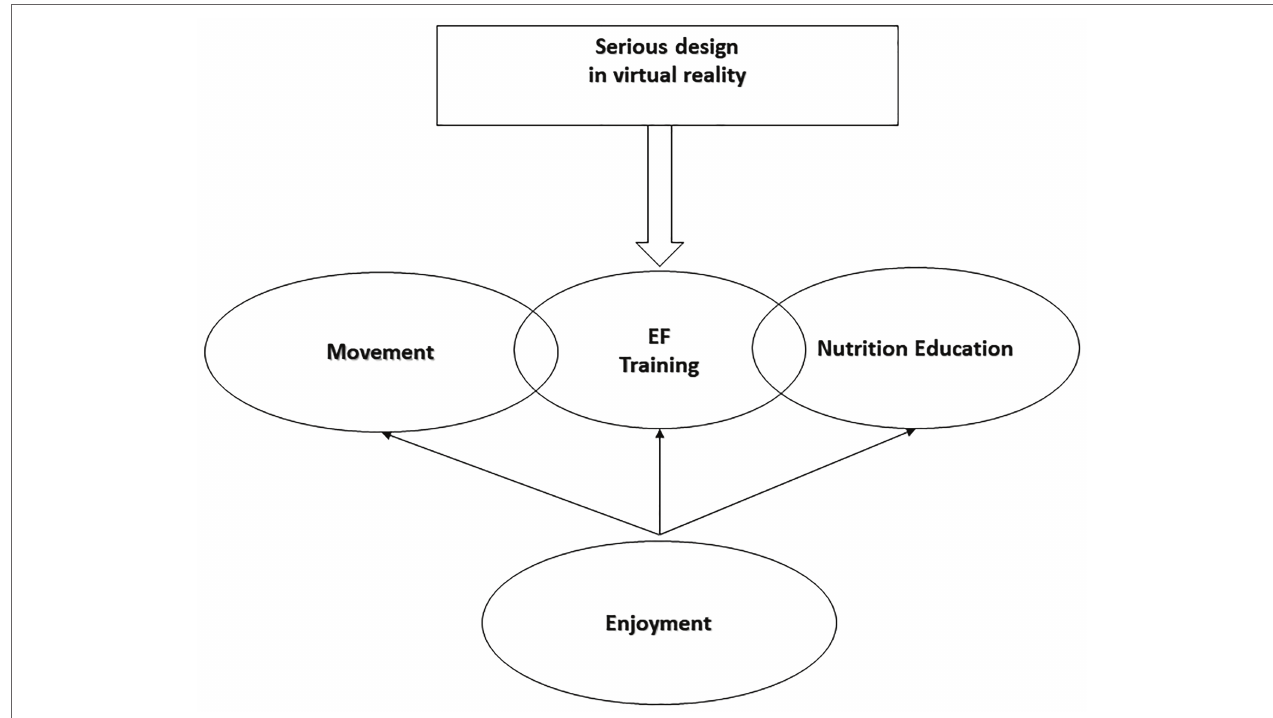
FIGURE 1 | The four-dimensional framework of a serious game in virtual reality: enjoyment, movement, nutrition education, and executive functioning (EF)